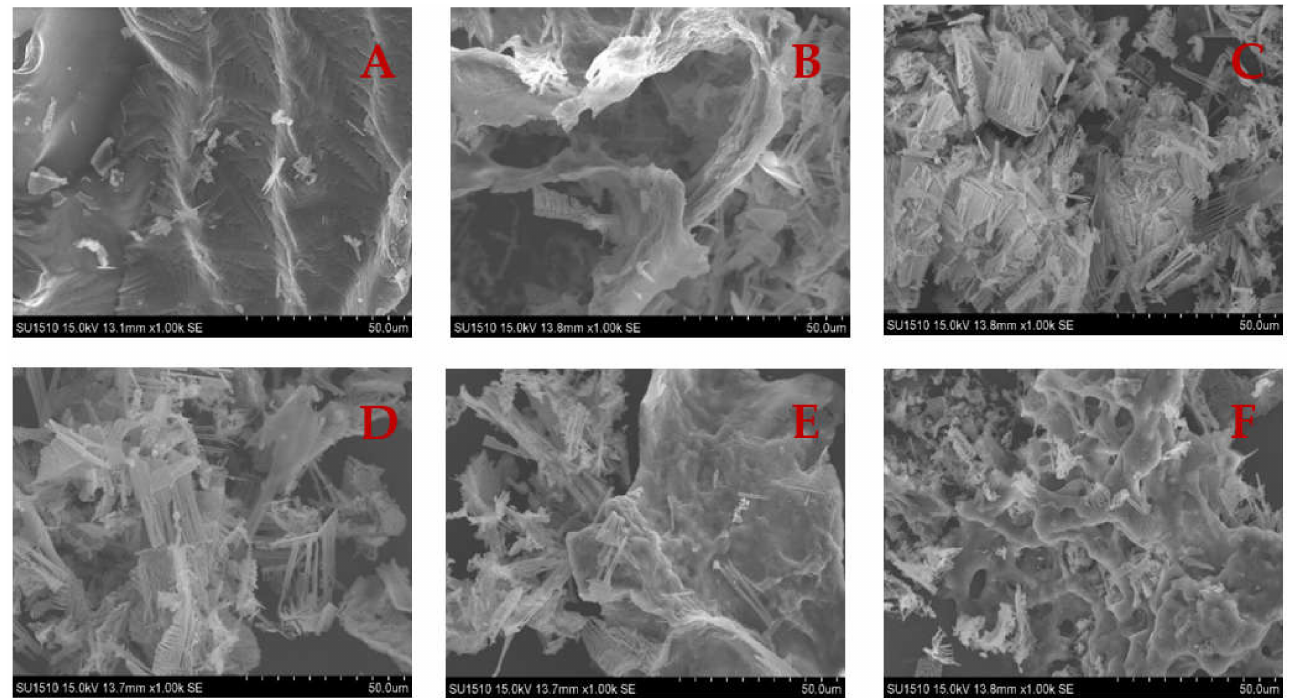
Figure 8. Microstructure of SCM under different heating conditions. ( A ) Control; ( B ) WH; ( C ) MH; ( D ) MWH1; ( E ) MWH2; ( F )